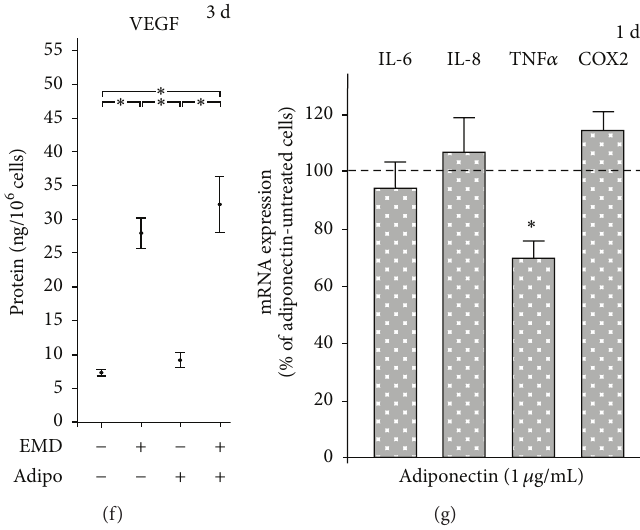
Figure 1: Effects of EMD and/or adiponectin (1 𝜇 g/mL) on the mRNA expression of TGF 𝛽 1, VEGF, POSTN, and RUNX2 at 1d (a) and 3 d (b). Untreated cells were used as control. Mean ± SEM ( 𝑛 = 18 ); ∗ significant ( 𝑃 < 0.05 ) difference between groups. Effects of various concentrations of adiponectin (0.3, 1, and 3 𝜇 g/mL) on the mRNA expression of TGF 𝛽 1 and VEGF in the absence (c) and presence (d) of EMD at 1d. Mean ± SEM ( 𝑛 = 9 ). Effects of EMD and/or adiponectin (1 𝜇 g/mL) on TGF 𝛽 1 (e) and VEGF (f) protein levels at 3 d. Unstimulated cells were used as control. Mean ± SEM ( 𝑛 = 18 ); ∗ significant ( 𝑃 < 0.05 ) difference between groups. Effects of adiponectin (1 𝜇 g/mL) on the IL-6, IL-8, TNF 𝛼 , and COX2 mRNA expressions at 1d (g). Unstimulated cells were used as control. Mean ± SEM ( 𝑛 = 15 ); ∗ significantly ( 𝑃 < 0.05 ) different from